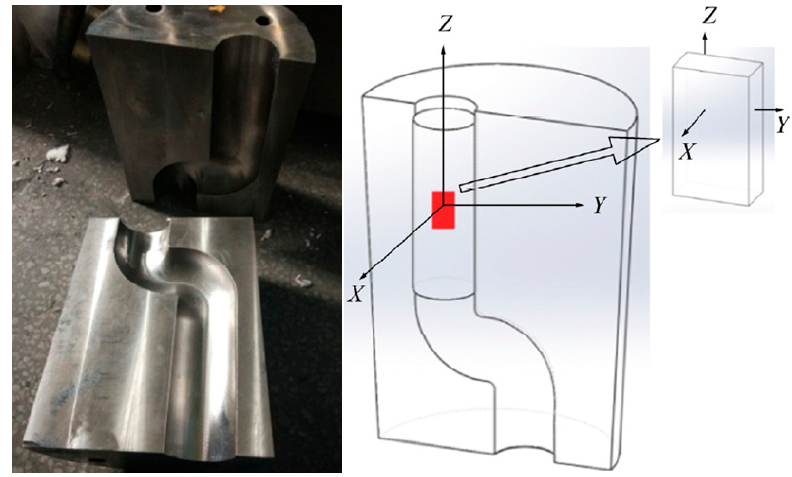
Figure 13. Schematic diagrams of ECRE process.